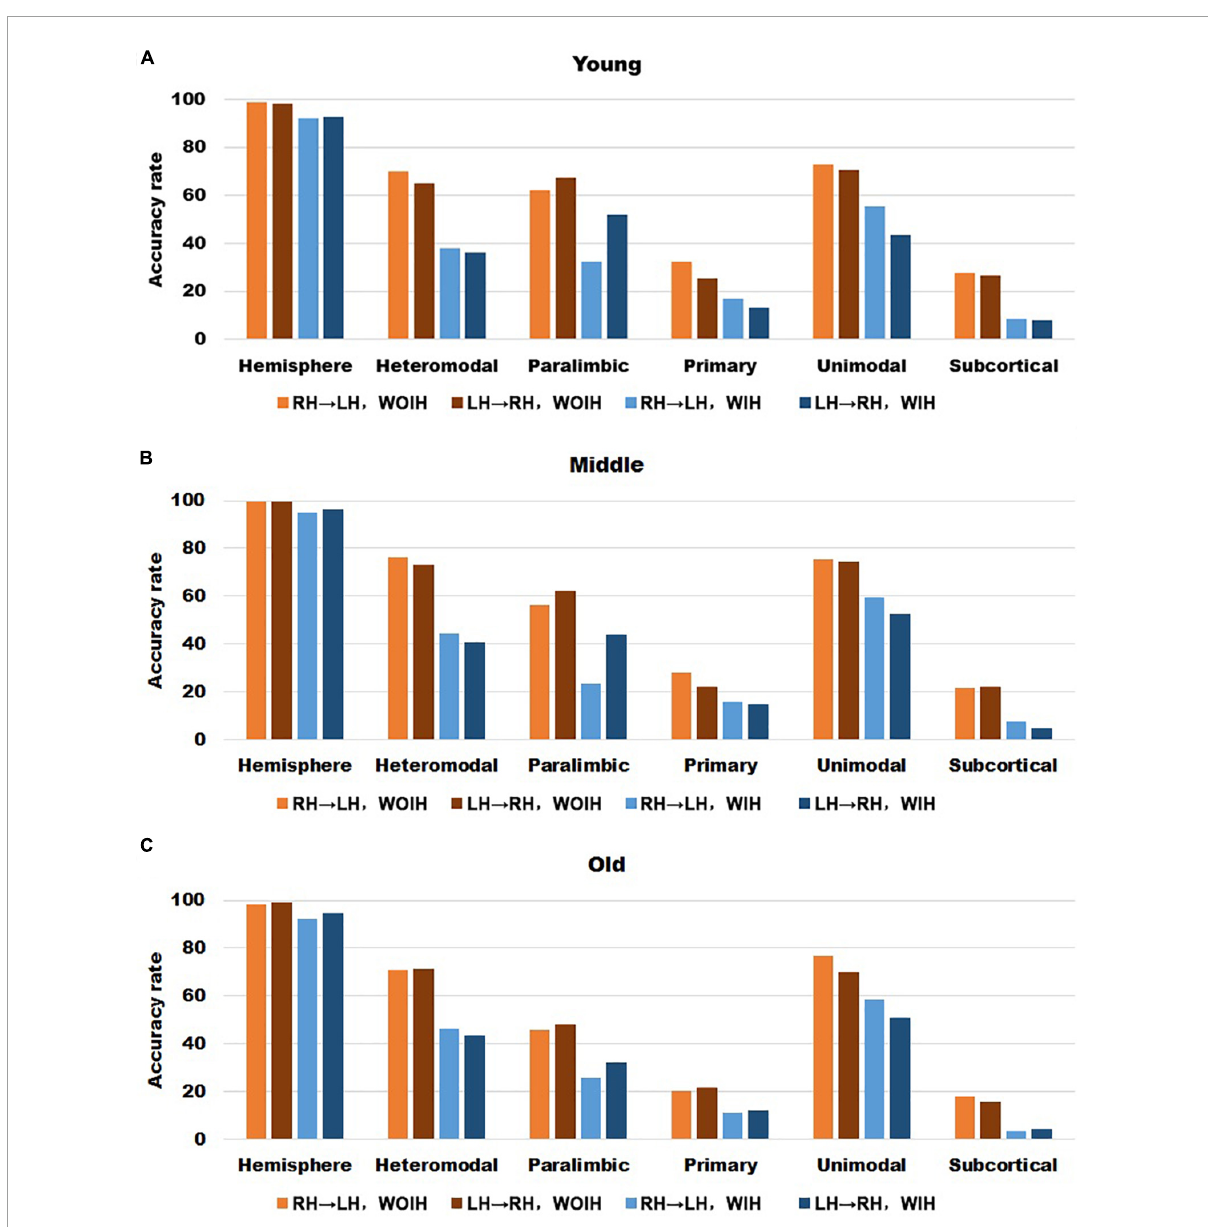
FIGURE7 The recognition rate results of hemisphere and each sub-module in different age groups for BNA template with GSR. (A–C) Represents the recognition rate of young, middle and old, respectively. From left to right in each sub graph, the recognition rate of hemisphere and five sub-modules are in turn. Notably, orange indicates that the RH recognizes the LH Without Ipsilateral Hemisphere (RH → LH, WOIH). Brown indicates that the LH recognizes the RH Without Ipsilateral Hemisphere (LH → RH, WOIH). Light blue indicates that the RH recognizes the LH With Ipsilateral Hemisphere (RH → LH, WIH). Dark blue indicates that the LH recognizes the RH With Ipsilateral Hemisphere (LH → RH,